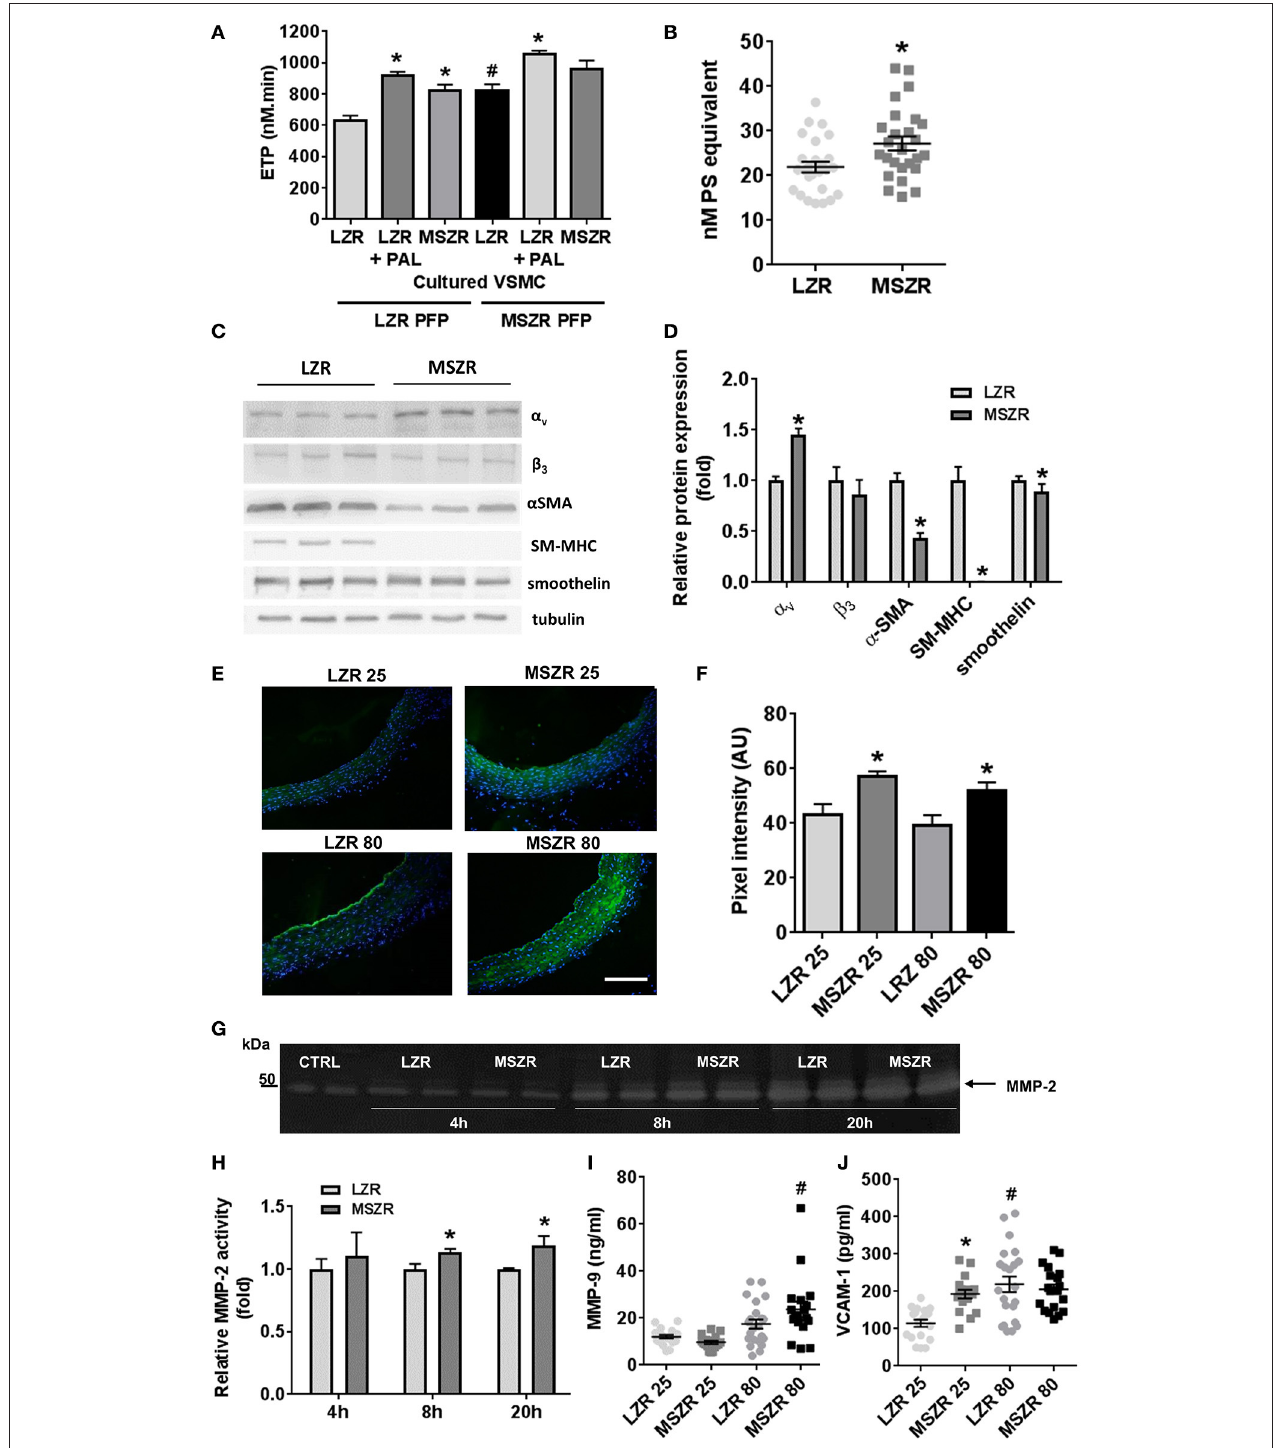
FIGURE 4 | Role of smooth muscle cells in thrombin generation. (A) ETP values measured at the surface of vascular smooth muscle cells (VSMCs) from LZR and MSZR, with LZR or MSZR platelet free plasma (PFP), and with or without 1.5 g/l exogenous added palmitic acid (PAL). Results are mean ± standard error of the mean, n = 3 with 6 wells per condition per experiment. * p < 0.05 vs. LZR VSMC, # p < 0.05 vs. LRZ PFP and LRZ VMSC. (B) VSMC associated procoagulant activity reported as phosphatidylserine (PS) equivalent in LRZ and MSZR. Results are mean ± standard error of the mean ( n = 25). * p < 0.05 vs. LZR. (C) Typical Western blot and (D) quantification analysis of VSMC differentiation markers ( α SMA, SM-MHC, and smoothelin) and integrin subunits ( α v and β 3 ) in cultured VSMCs.